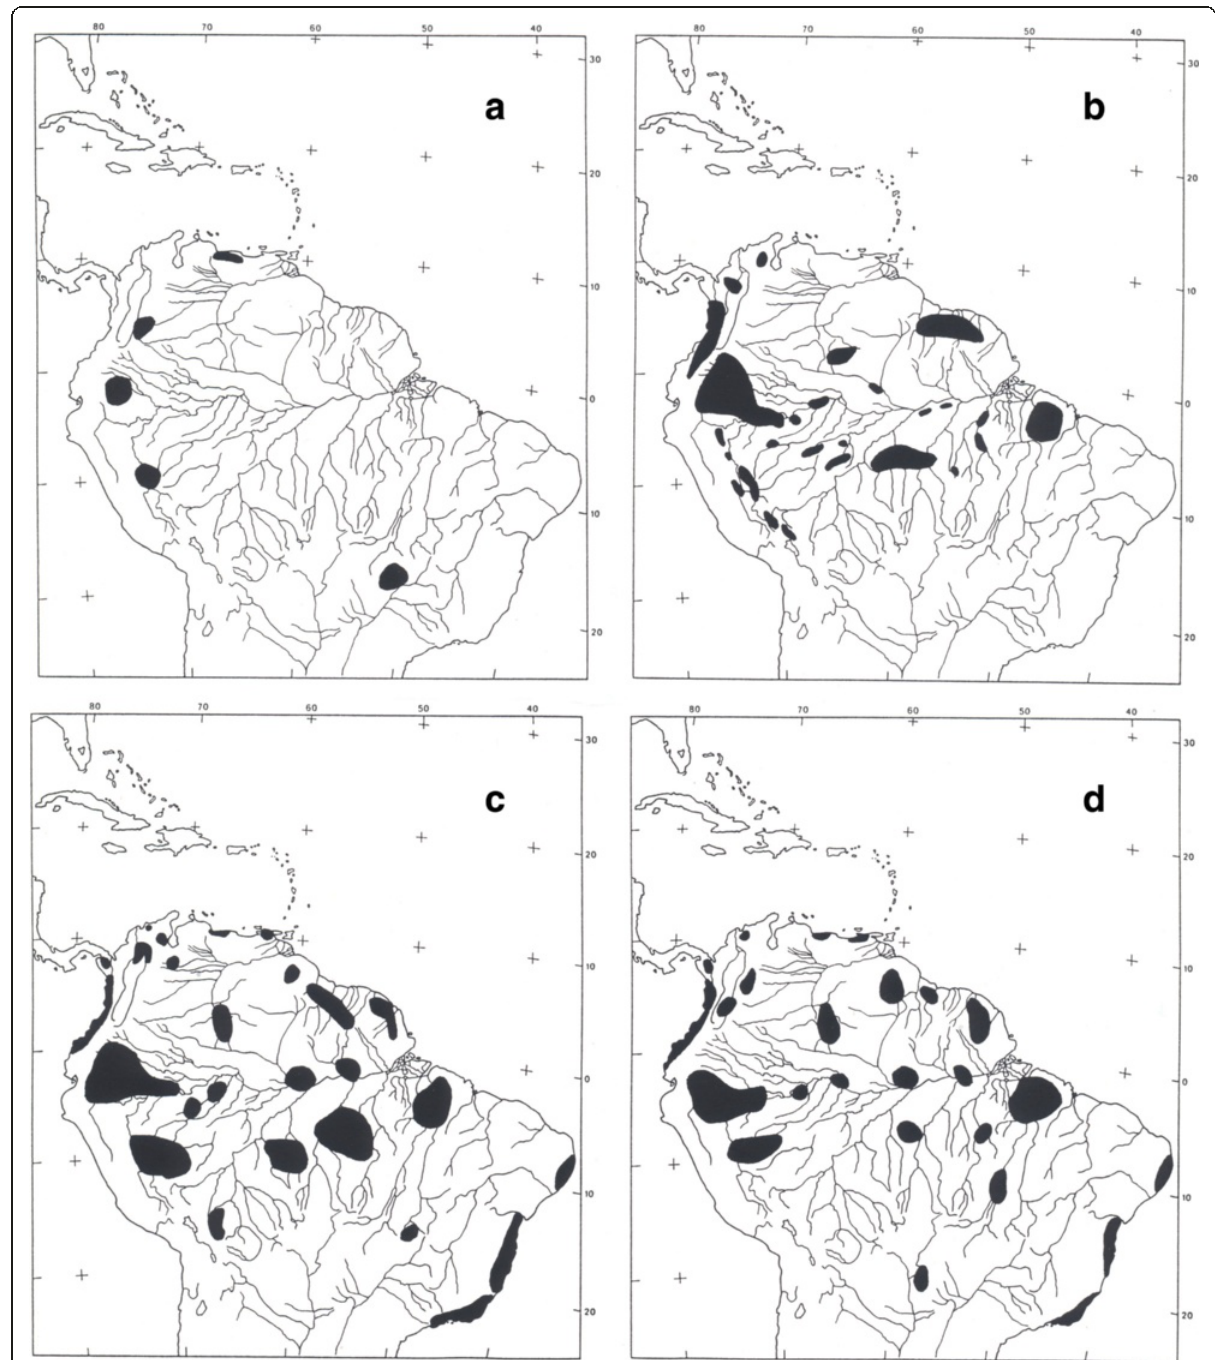
Fig. 28 Refugia defined for several taxa in tropical South America: a lizards [149]; b birds [156, 157]; c woody plants [82] and d